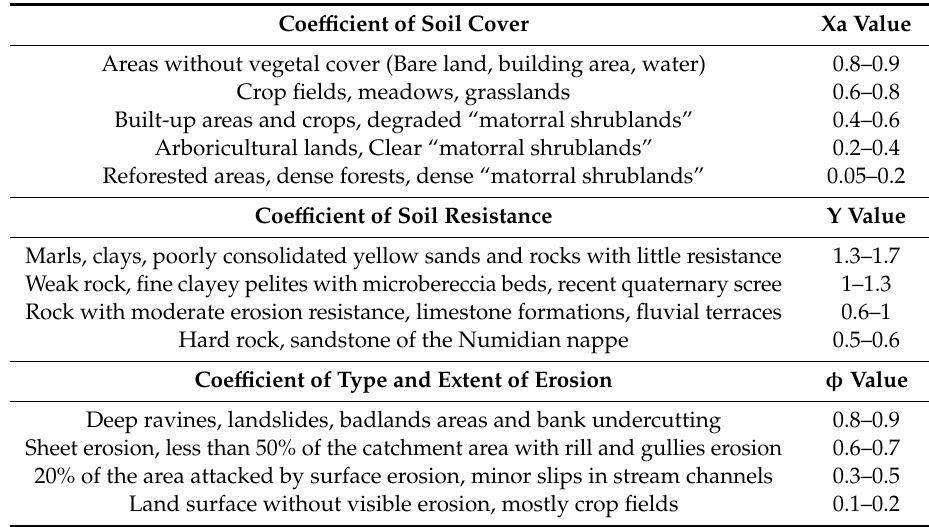
Table 2. Values of the factors used in the intensity of erosion and outflow (IntErO) / EPM method [19,37]. Coe ffi cient of Soil